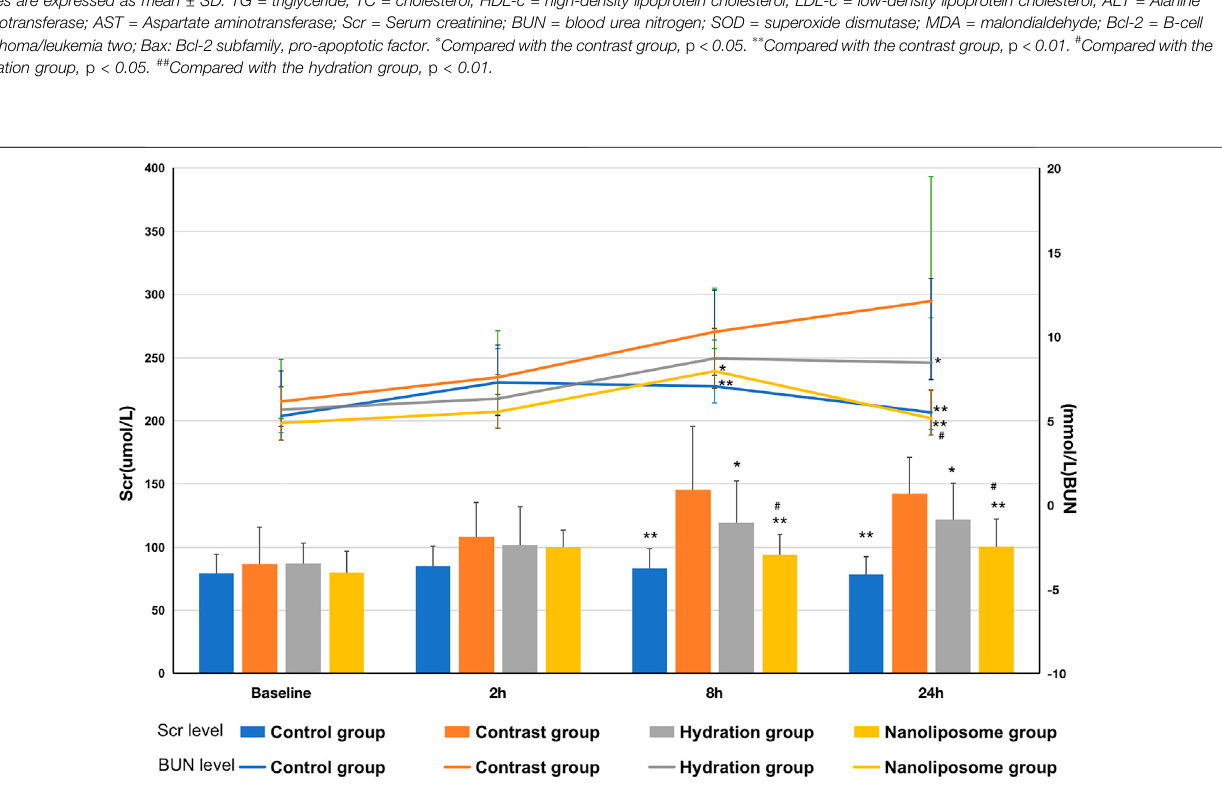
Frontiers in Molecular Biosciences |